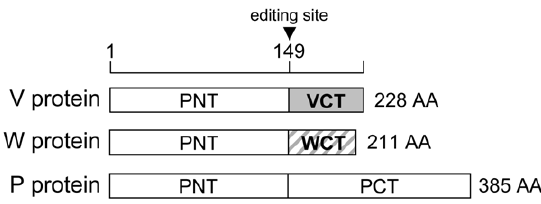
Figure 1. The gene P of TioV encodes for three proteins: V, W and P. Whereas conventional transcription and translation lead to the expression of TioV-V, co-transcriptional insertion of one G residue at the editing site by the viral RNA polymerase leads to the expression of a chimeric protein called W. Insertion of two G residues can also occur during transcription, thus leading to the expression of the phospho- protein P.